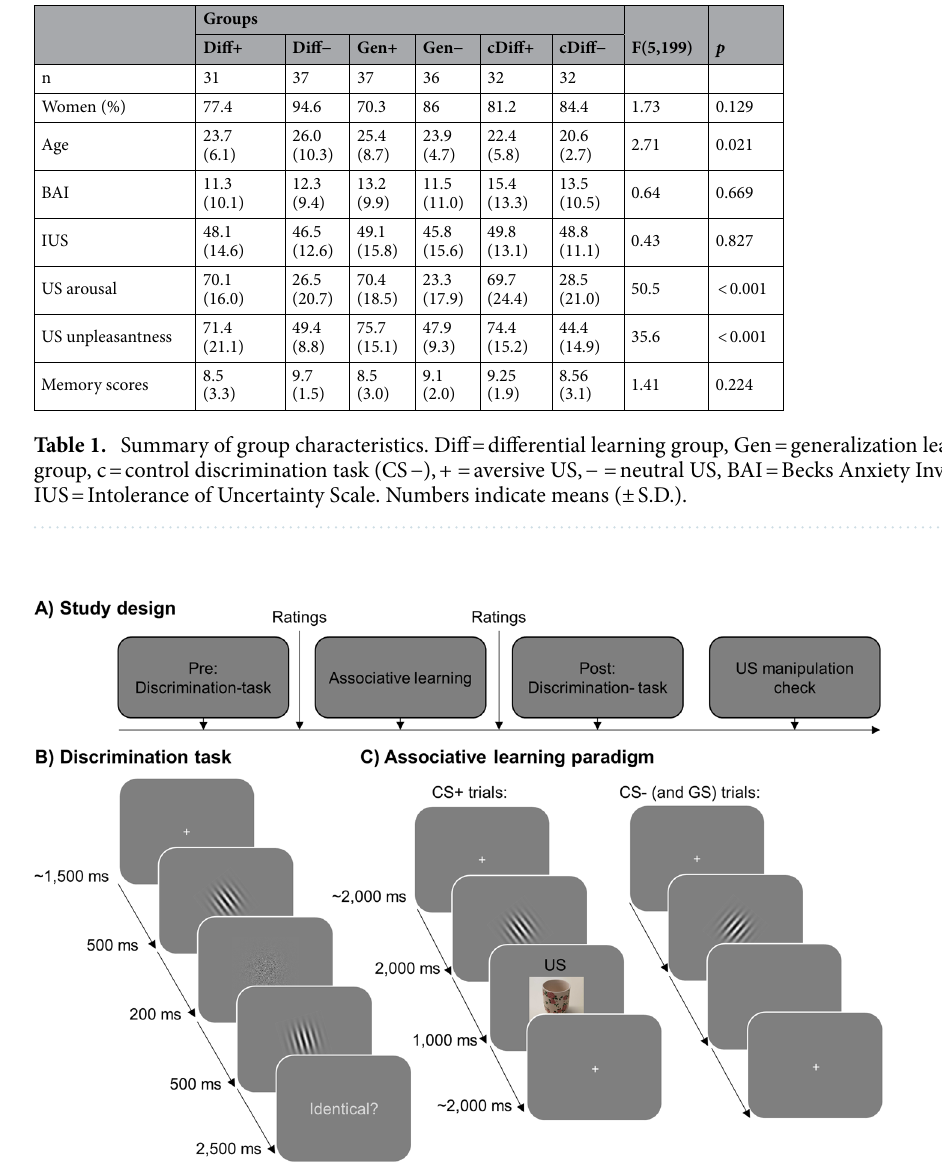
Figure 1. ( A ) Flowchart of the general experimental design. ( B ) Trial structure and timing of the visual discrimination task. Crucially, at least one of the grating stimuli was always the later CS+ (CS− for control groups, cDiff+ and cDiff −). ( C ) Trial structure and timing of the associative learning task. CS+ trials were always followed by a 1.000 ms presentation of a US (either a neutral or an unpleasant picture stimulus), while CS− trials (and all GS trials for generalization groups, Gen+ and Gen−) remained unpaired. Note: The US depicted in this figure is an example and differs from the pictures used in the original